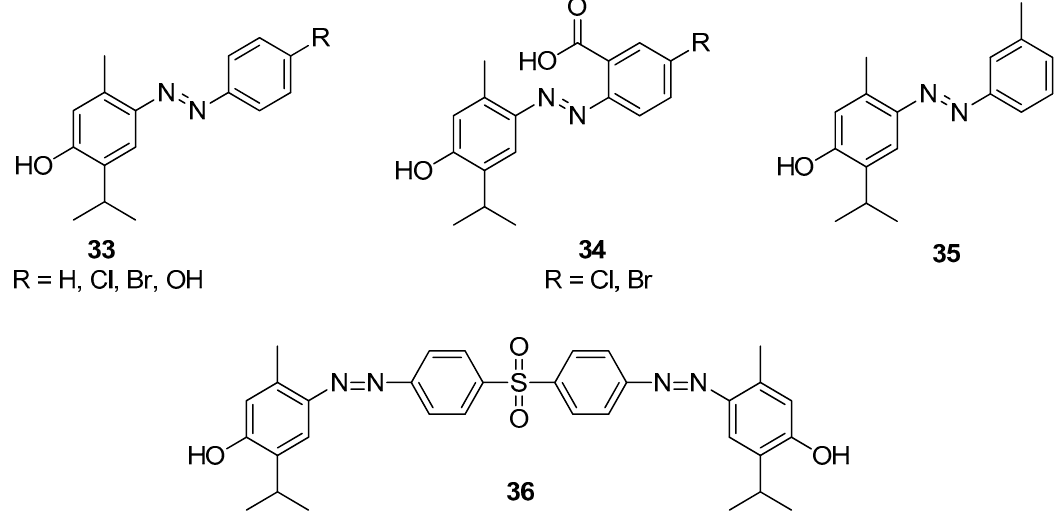
Figure 9. Selected aryl-azo-thymol derivatives with significant antibacterial and antifungal activities.